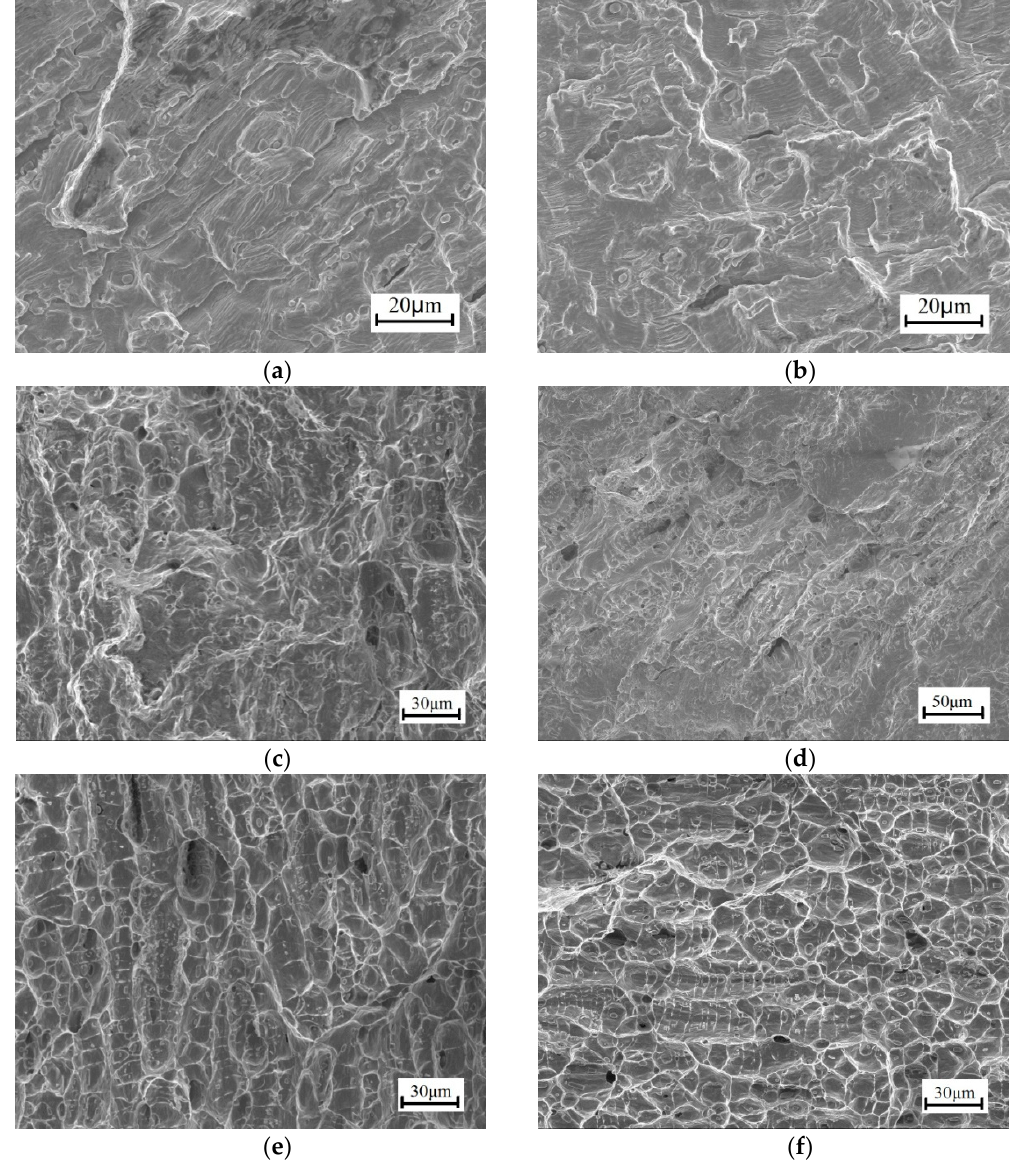
Figure 11. Scanning electron micrographs of the fatigued copper specimen under a ±50 MPa loading level: ( a ) Crack propagation region without EPT; ( b ) crack propagation region with EPT; ( c ) unstable crack growth region without EPT; ( d ) unstable crack growth region with EPT; ( e ) final fracture region without EPT; ( f ) final fracture region with EPT.